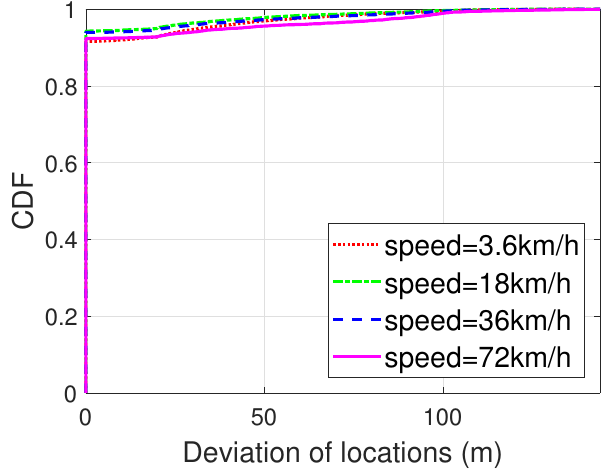
Figure 9. CDF of deviation of retrieved locations with different